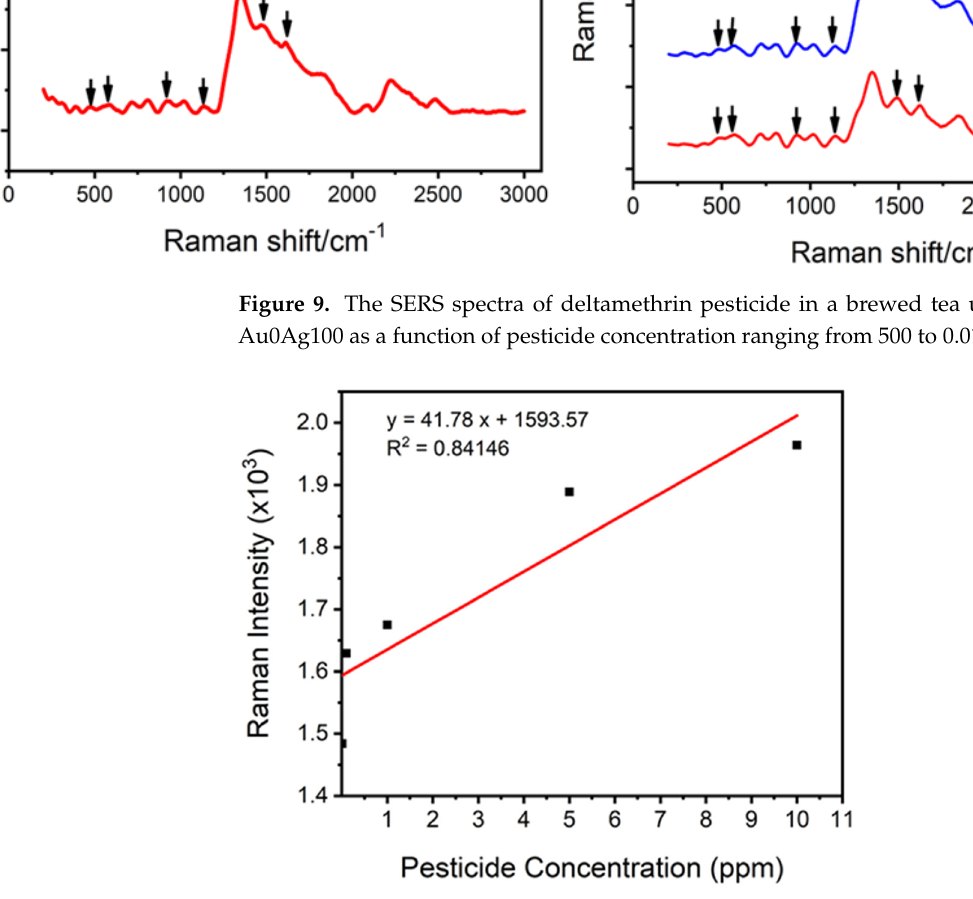
Figure 10. Standard curve of pesticide in brewed tea from 0.01 to 10 ppm.